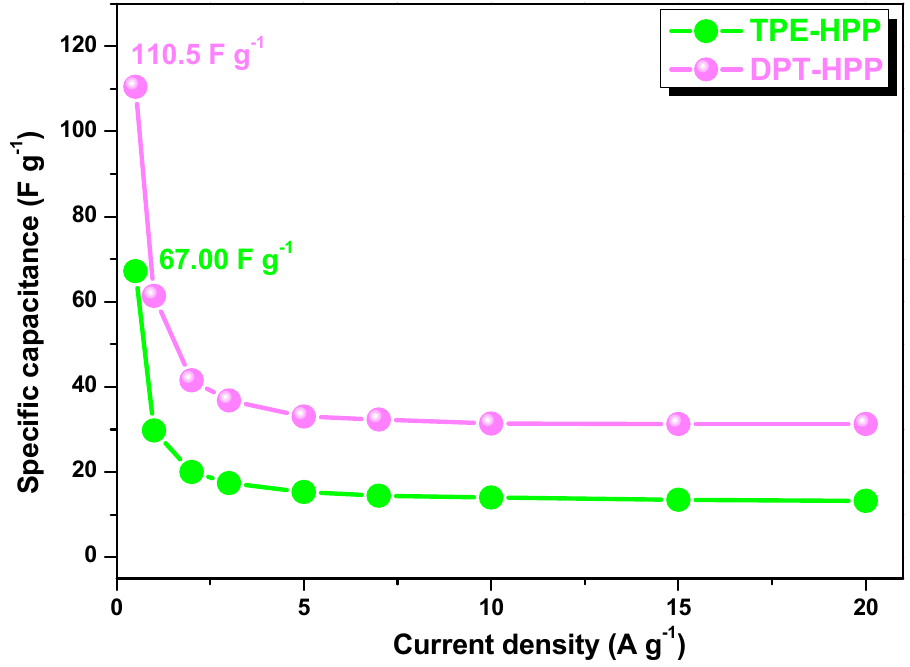
Figure 11. Specific capacitances profile of TPE-HPP and DPT-HPP recorded at various current densities.